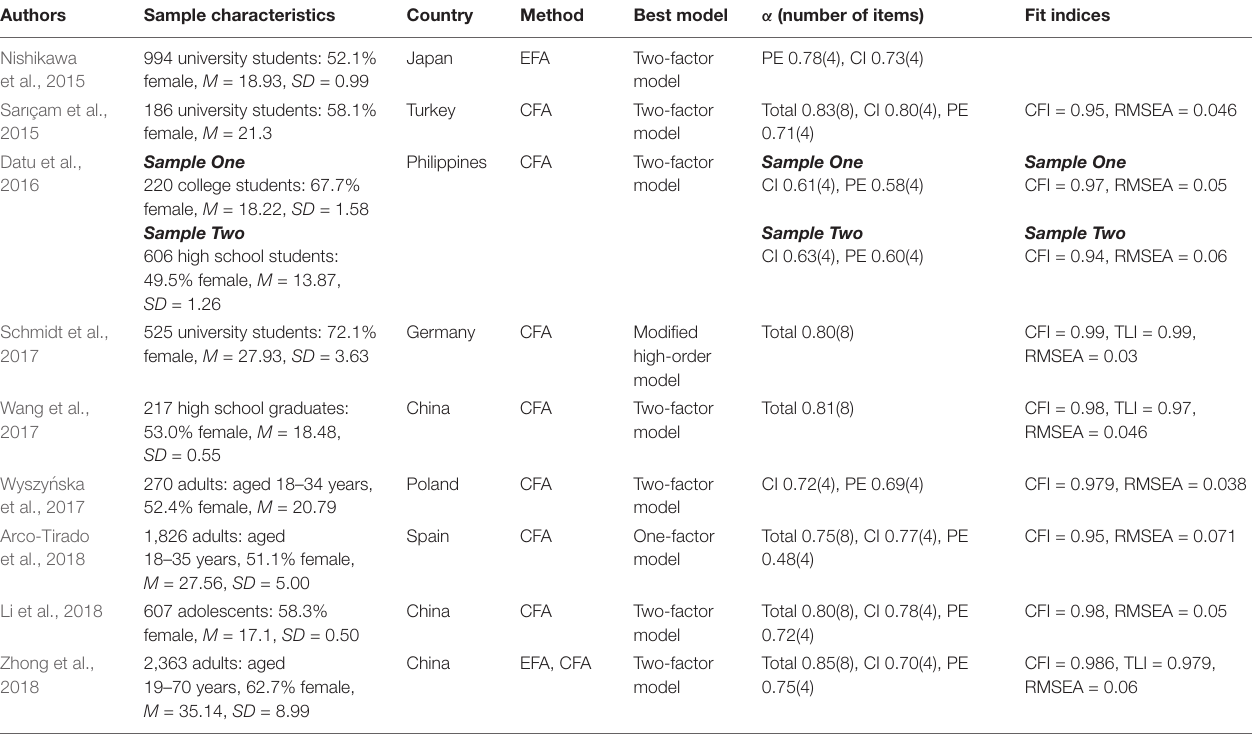
TABLE 1 | Psychometric properties in previous studies for the